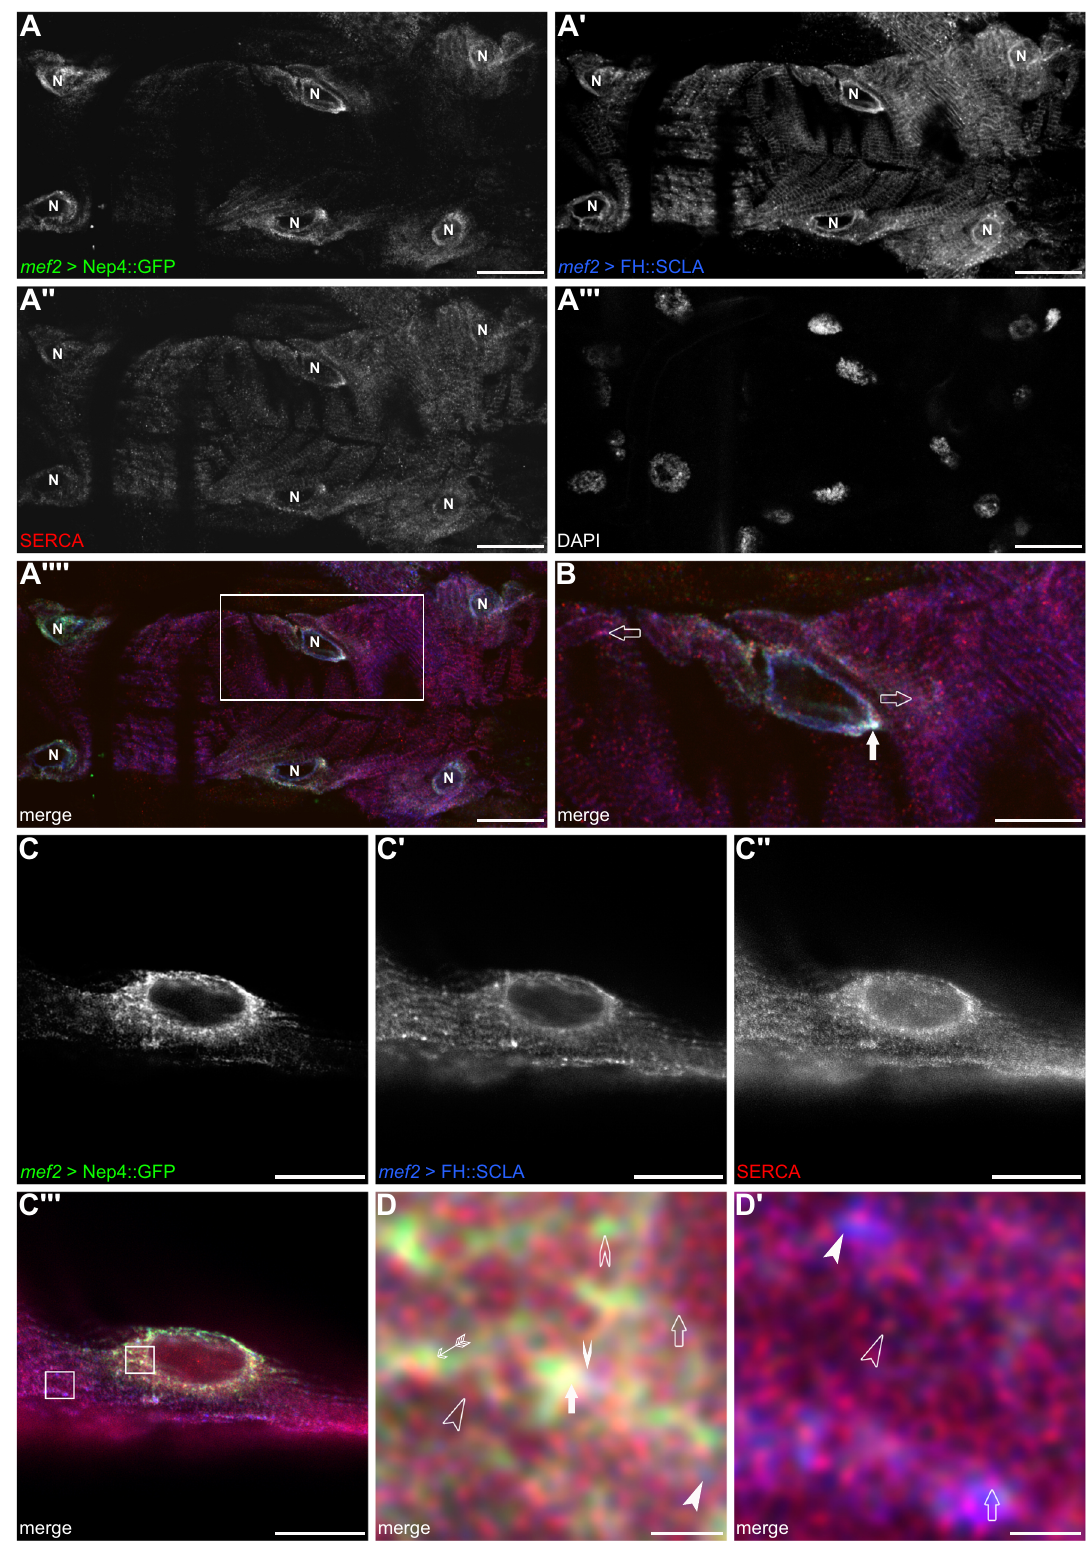
co-expression of Nep4 or NEP resulted in partial relocalization of the peptides to the cytoplasm, asindicated by reduced signaloverlap with the ER marker Calnexin (Fig. 6A, arrowheads), suggesting a reduced membrane association of the cleaved peptides. To corroborate this indication,weanalyzedcytoplasmicandmembrane-enrichedfractions generated from correspondingly transfected S2 cells by